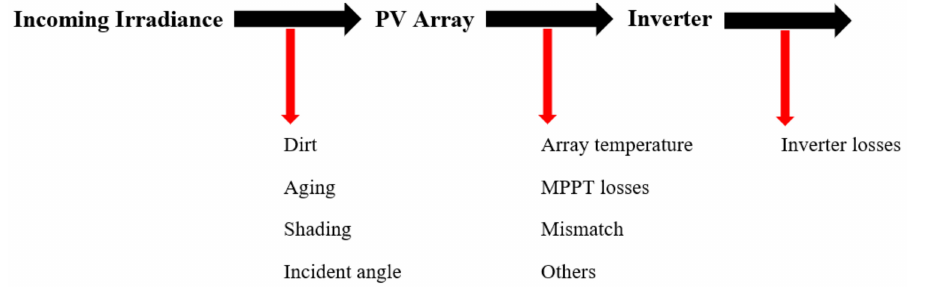
Figure 7. Factors in the power losses of the PV system